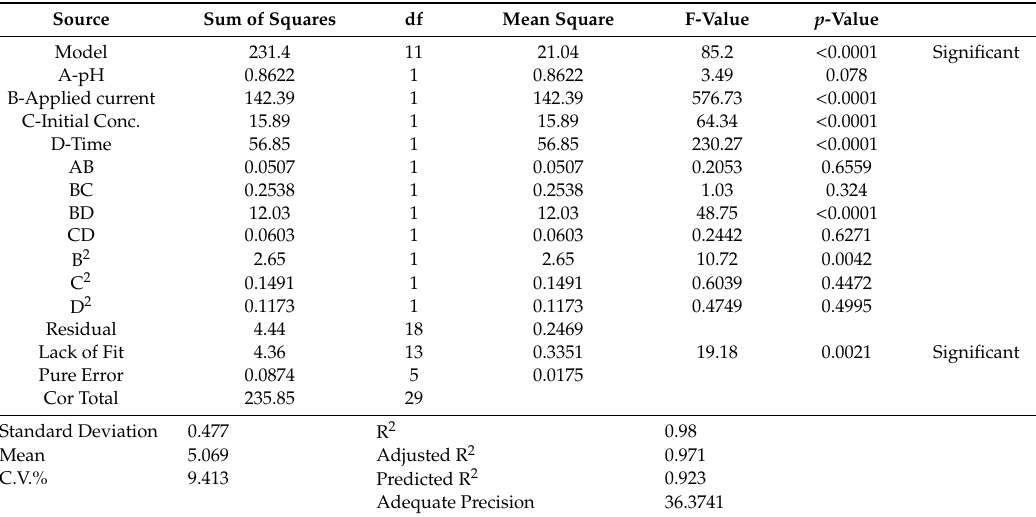
Table 3. ANOVA for energy consumption